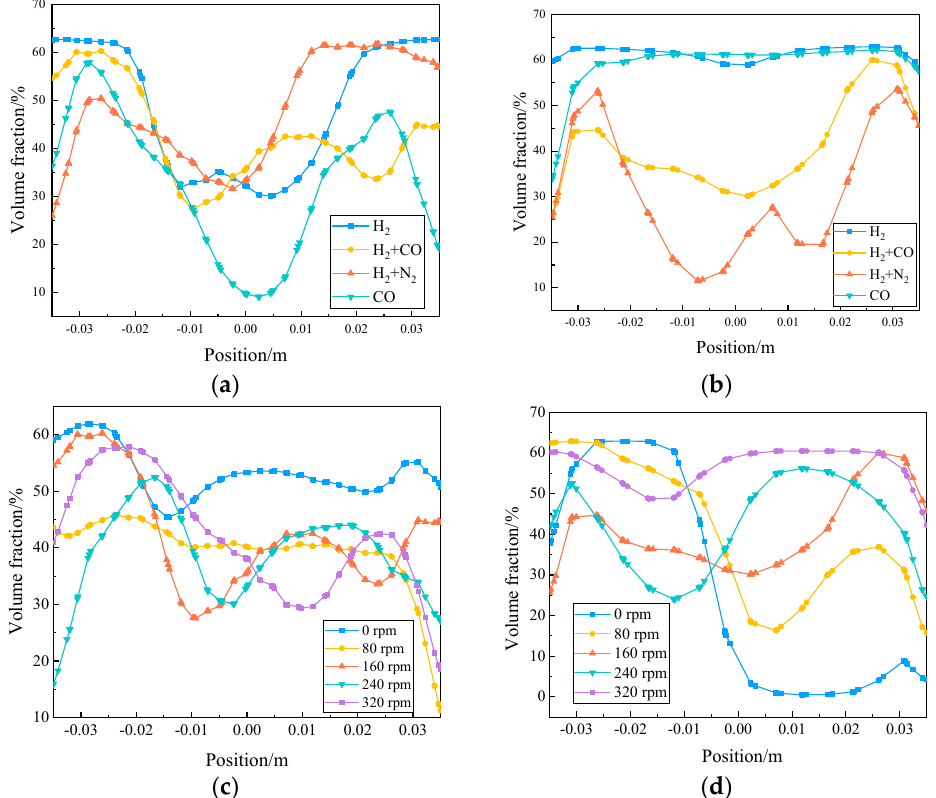
Figure 5. Radial volume fraction distribution of iron ore powder particles at the height of 0.07 and 0.21 m. ( a ) Different gas compositions at 0.07m; ( b ) Different gas compositions at 0.21m; ( c ) Different agitation speeds at 0.07m; ( d ) Different agitation speeds at 0.21m.